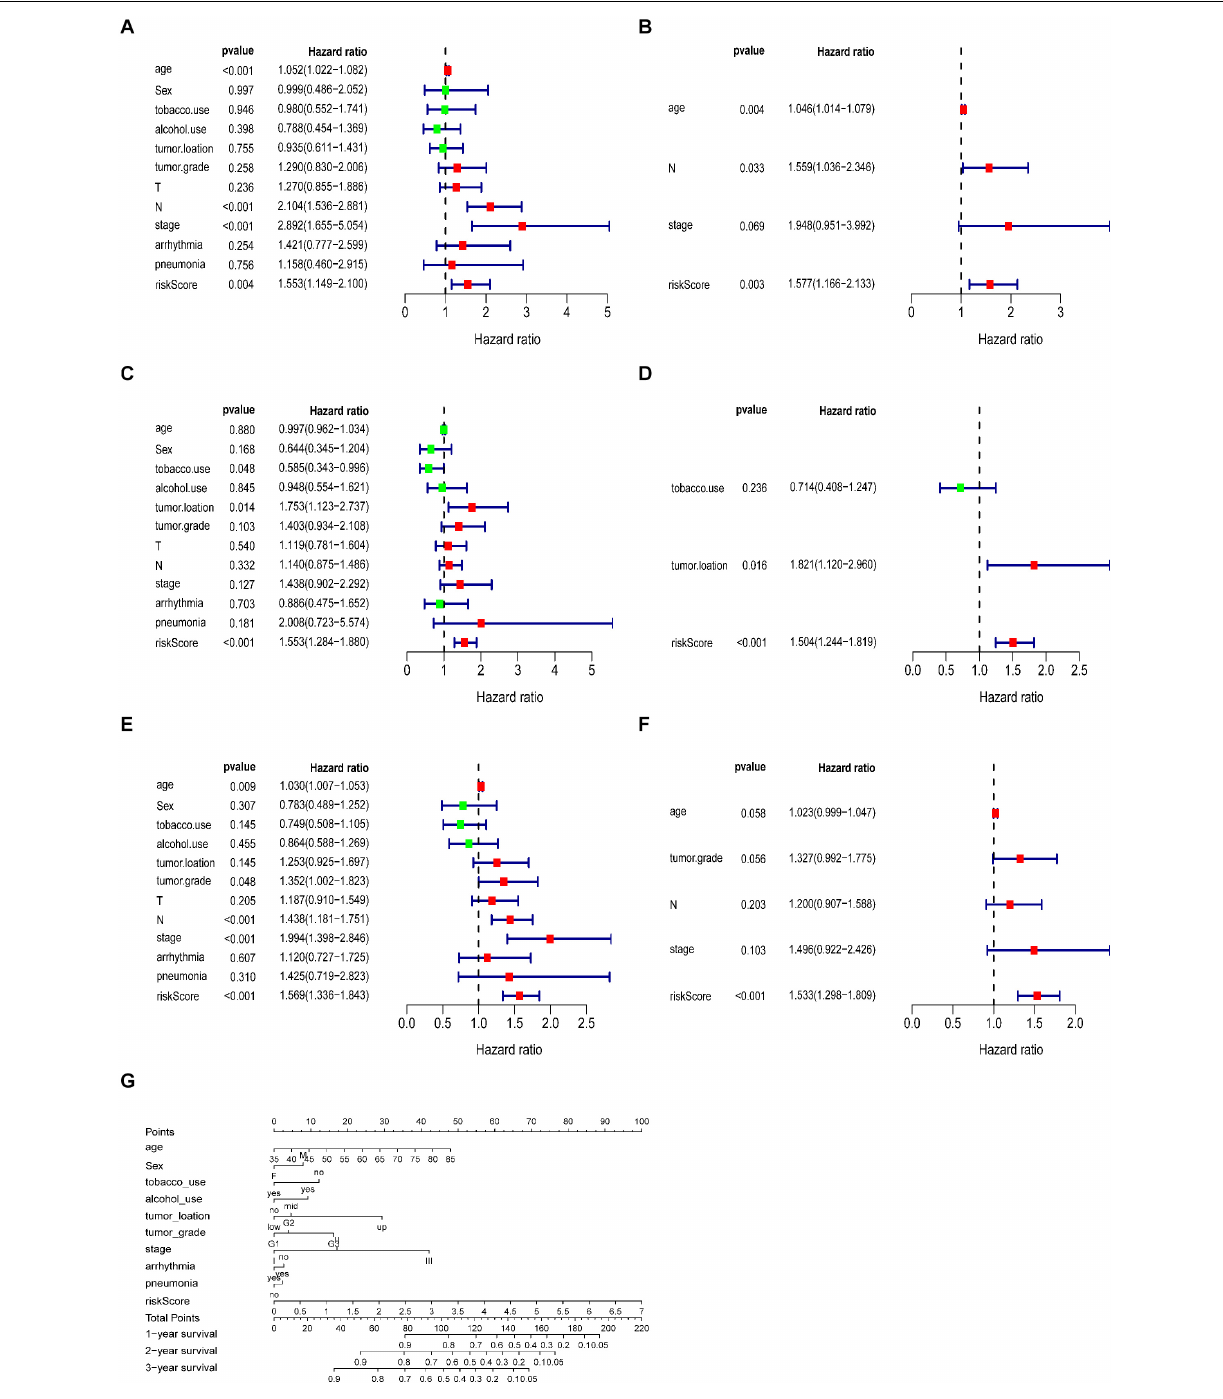
and metastasis of ESCC (Wang et al., 2017; Lu et al.,